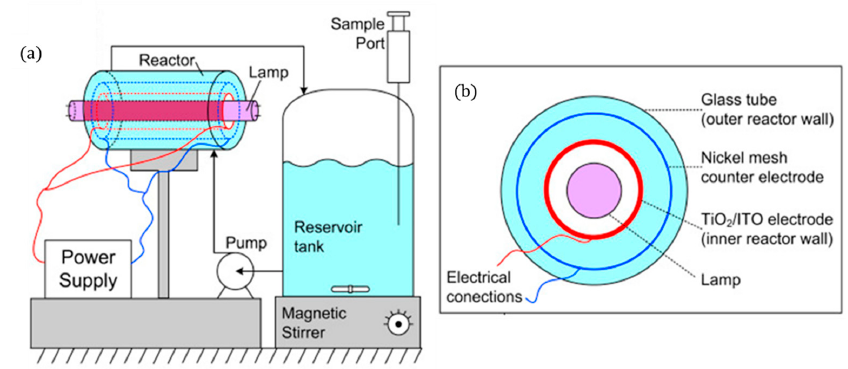
Figure 9. ( a ) Schematic representation of the experimental set-up, ( b ) PEC reactor cross-sectional view. (Adapted with permission from [46]: Pablos, C.; Marugán, J.; Adán, C.; Osuna, M.; van Grieken, R. Performance of TiO 2 photoanodes toward oxidation of methanol and E. coli inactivation in water in a scaled-up photoelectrocatalytic reactor. Electrochim.